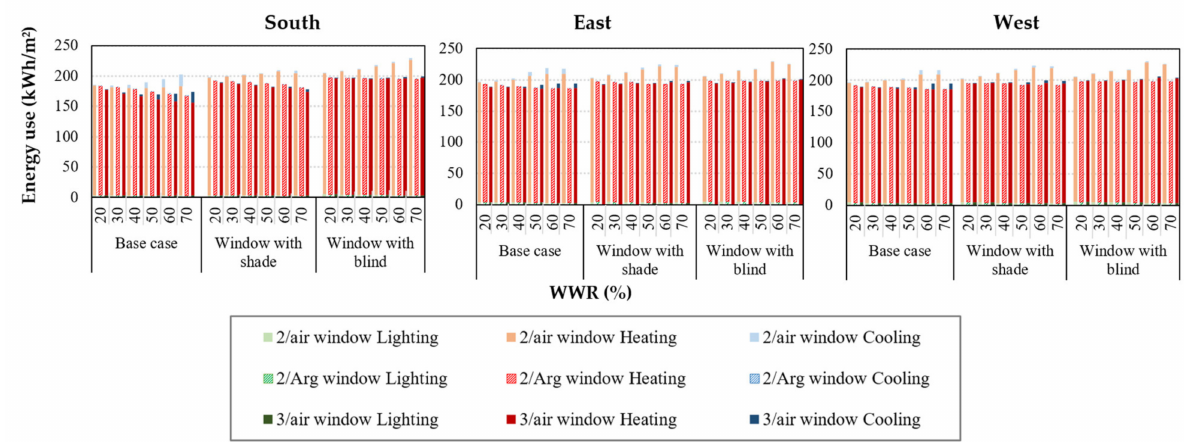
Figure 12. Lighting, cooling, and heating energy use as a function of WWR (%) for three window types (2/air, 2/Arg, and 3/air windows) for south, east and west orientations of buildings located in Snow, fully humid climate with cold summer